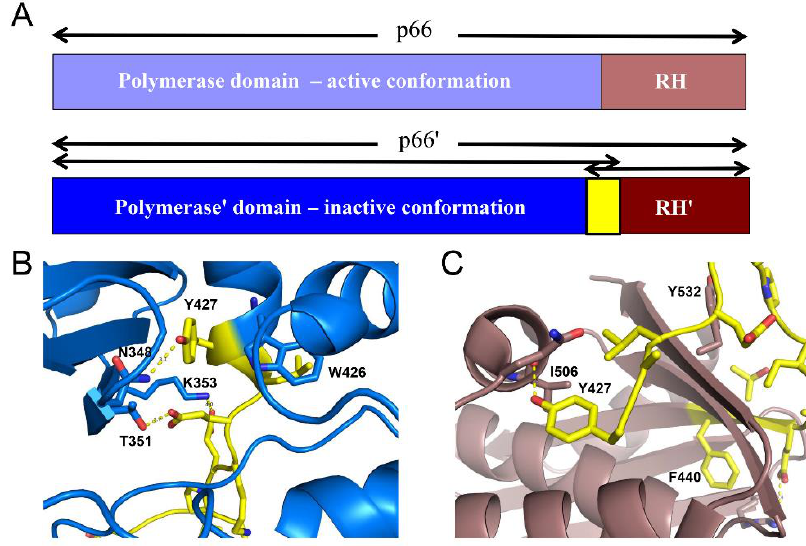
Figure 11. A tug-of-war for the residues at the N-terminus of the RNase H domain. ( A ) domain structure of the p66 and p66’ subunits, color coded as: polymerase (blue), RH (brown), and residues present in both polymerase’ and RH’ domains in p66’ (yellow); ( B ) Ribbon diagram of the p51 subunit of RT containing residues up to the cleavage site, (PDB ID: 1RTJ, [33]); ( C ) Ribbon diagram of the supernumerary RH domain. Color coding in panels B and C as in A. In p66 M , the RH domain wins the tug-of-war, as the C-terminus of the connection unravels (Figure 3B). Formation of the dimer interface creates the cavity that binds α M’, facilitating the transfer of residues from RH’ to the polymerase’ (based on Figure 9 of [16]).